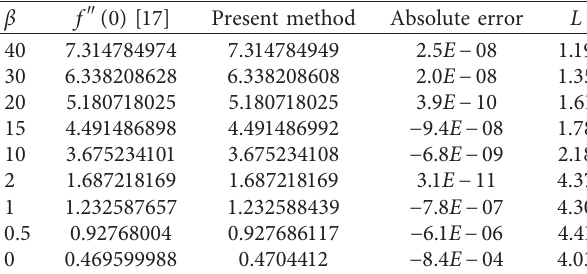
� 1 and different values of β . 0